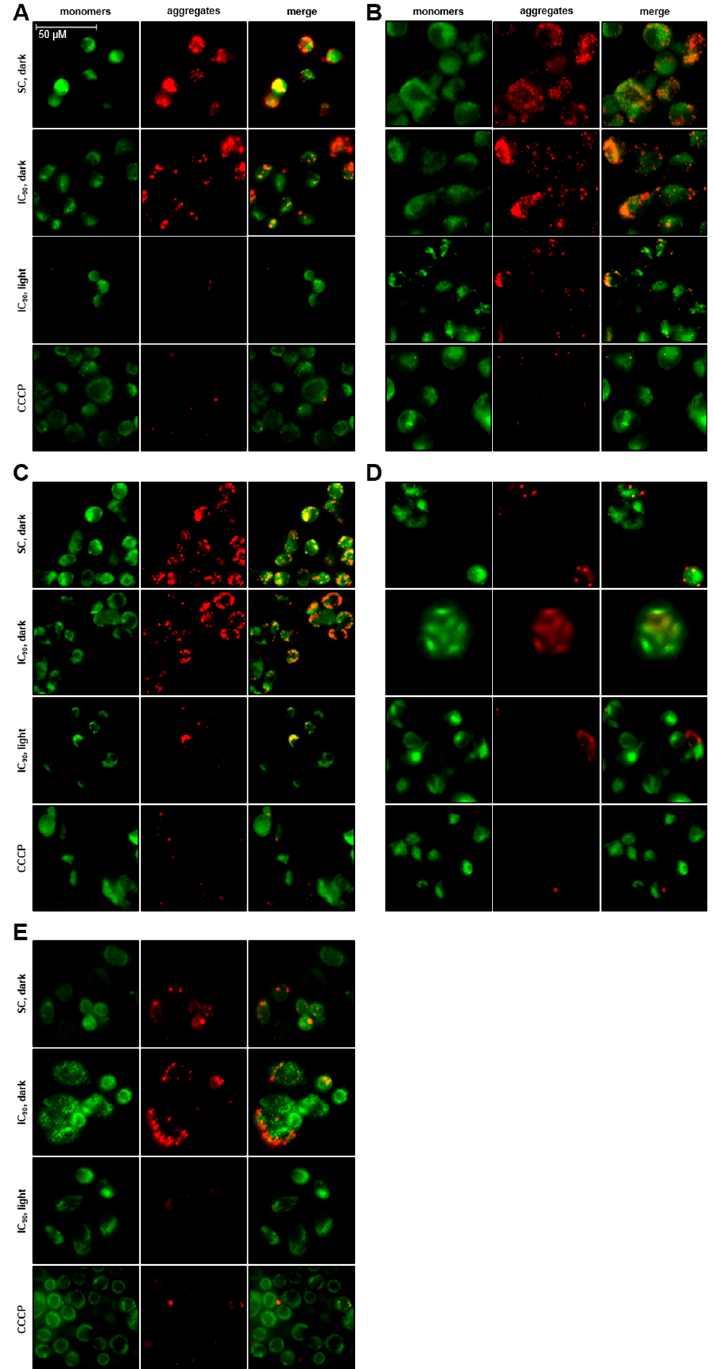
Figure 5. Evaluation of mitochondrial membrane potential ( Δ ψ m ) after mTHPC-PDT in A-427 ( A ), BHY ( B ), KYSE-70 ( C ), RT-4 ( D ), and SISO ( E ) cells. Cells were treated with solvent (SC) or equitoxic concentrations of mTHPC between 0.07–0.3 µM (equal to the respective IC 90 in Table 1), illuminated with 1.8 J/cm 2 or left in the dark, and stained with the cationic dye JC-1 after an incubation period of